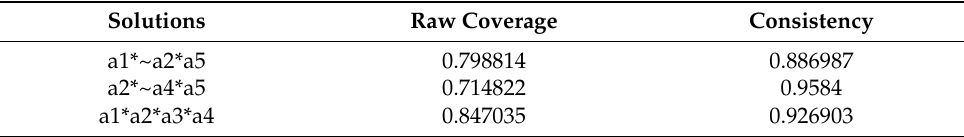
Table A4. Success pathways (outcome A1)- The mark * resembles “and”.